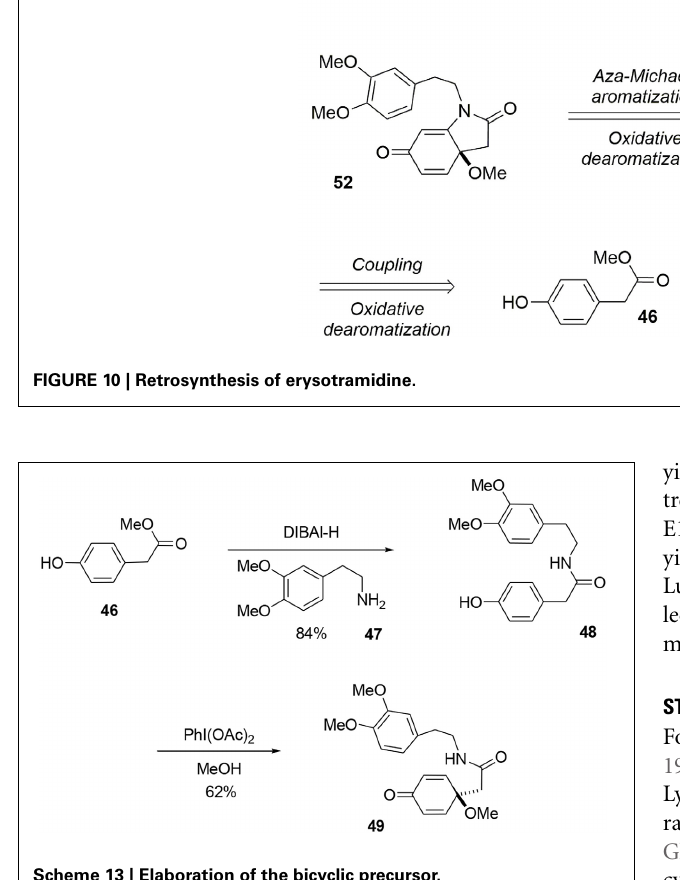
Scheme 13 | Elaboration of the bicyclic